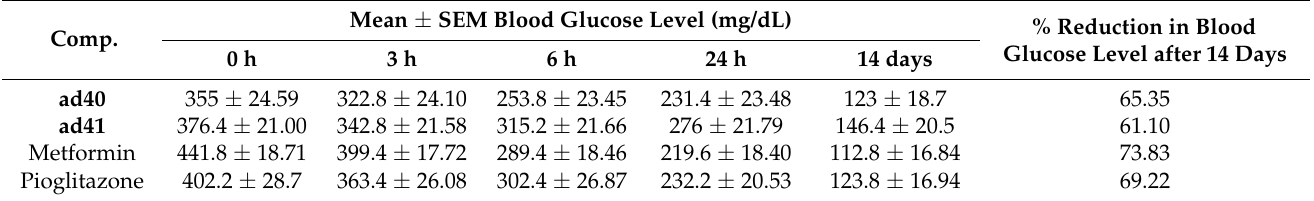
Table 47. Antidiabetic potential of the compounds ( ad40 – ad41 ) using the alloxan-induced model in rats.